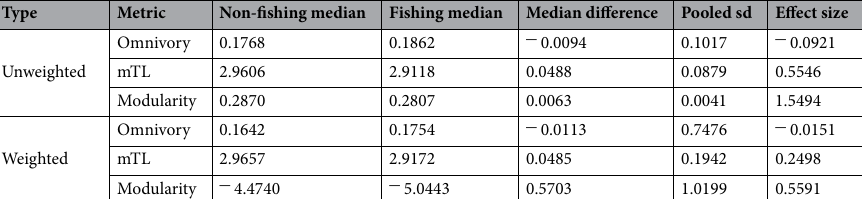
Table 2. Omnivory level, mean trophic level (mTL) and modularity values of the fishing and non-fishing model. For each metric, the median difference, pooled standard deviation and the magnitude of the effect size, estimated as the median difference over the pooled